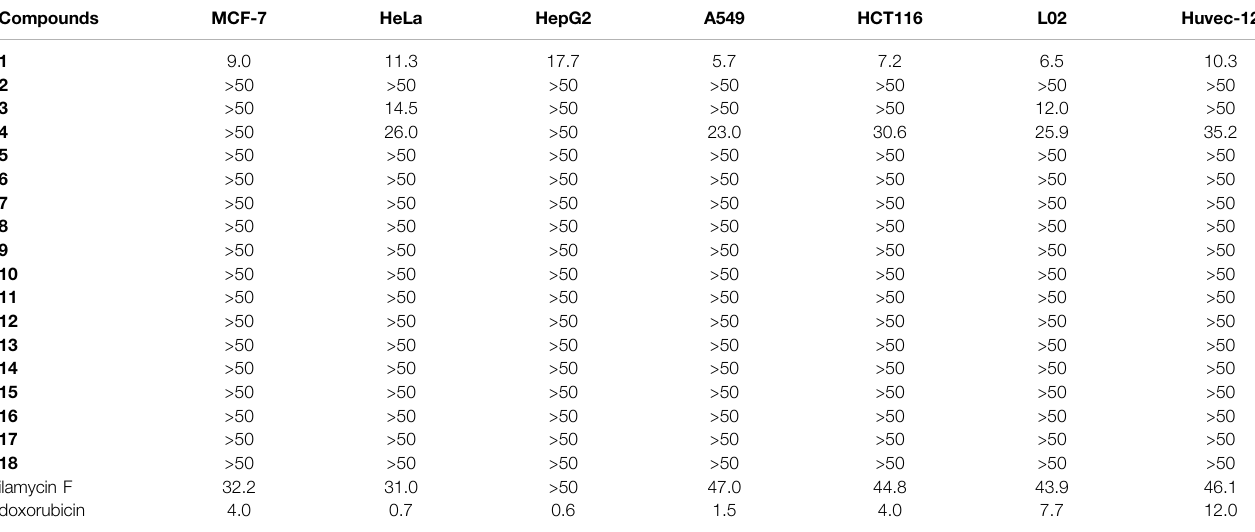
Compounds MCF-7